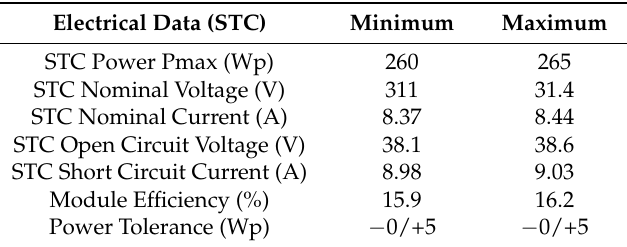
Table 2. Fronius Primo 7.6-1 technical data.